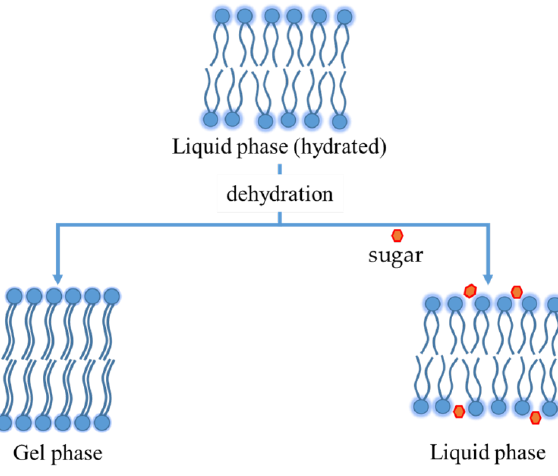
Figure 5. Phospholipids bilayer before and after dehydration, with and without sugar.